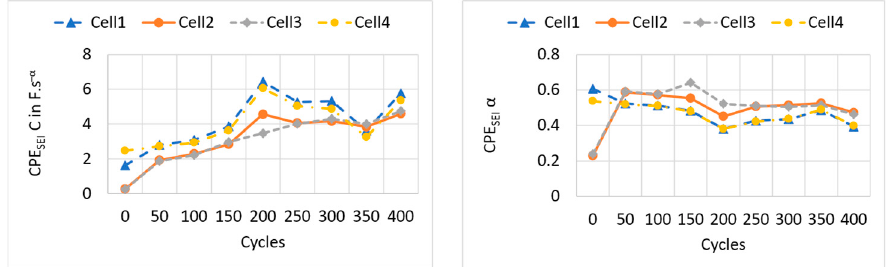
Figure 9. Data fitting results of all the ECM components.